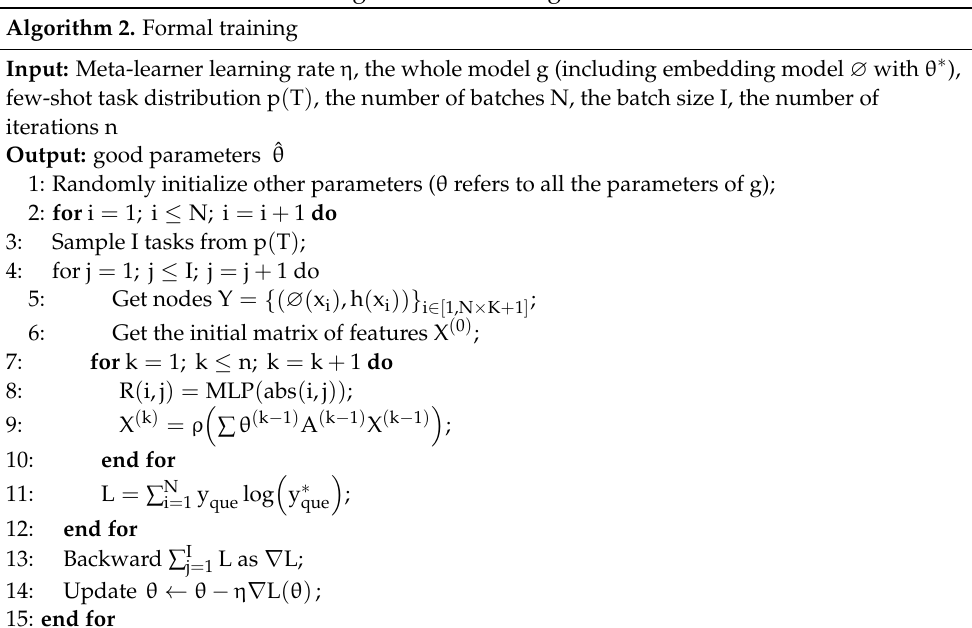
Algorithm 2. Formal training